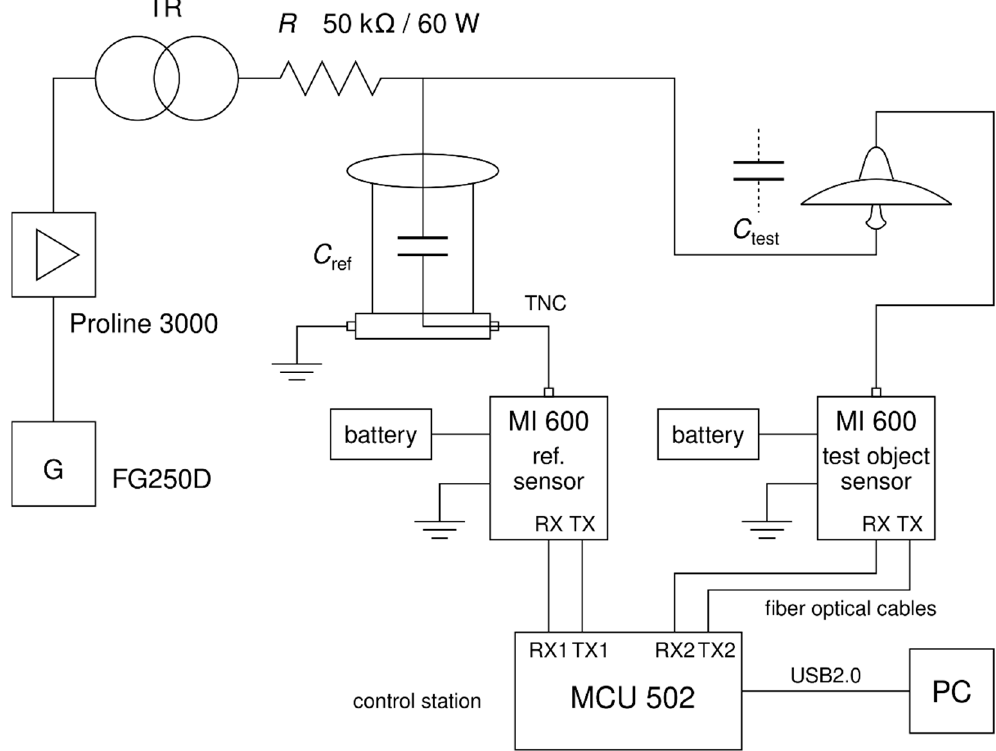
Figure 4. Measurement diagram for measurement with OMICRON MI 600.